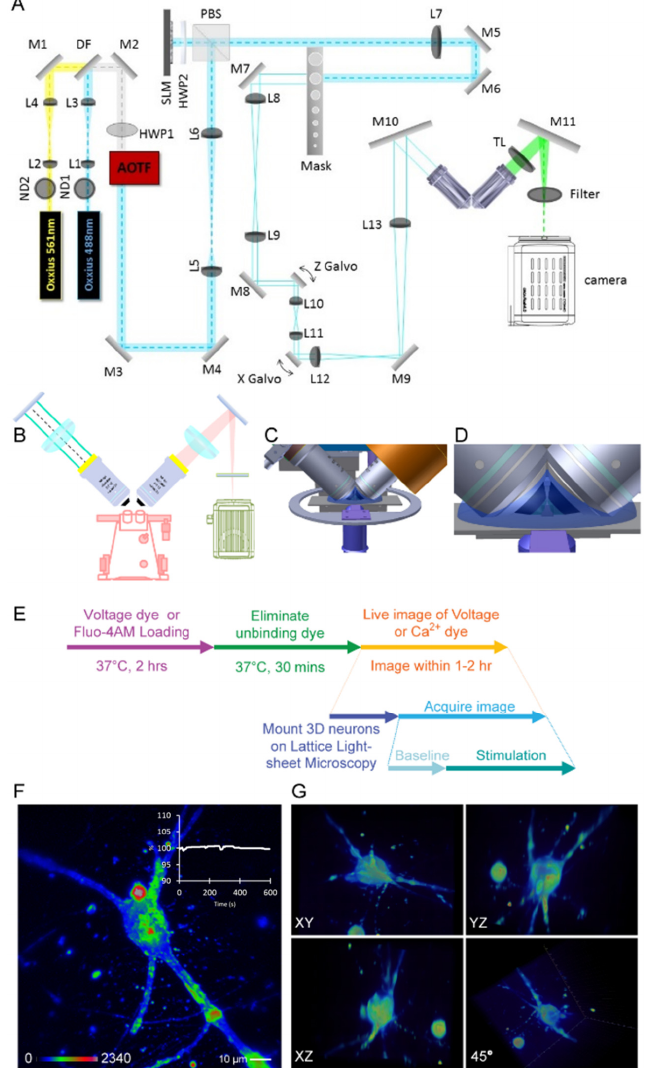
Figure 2. ( A ) The detailed optical schematic for the lattice light-sheet microscopy (LLSM) system.